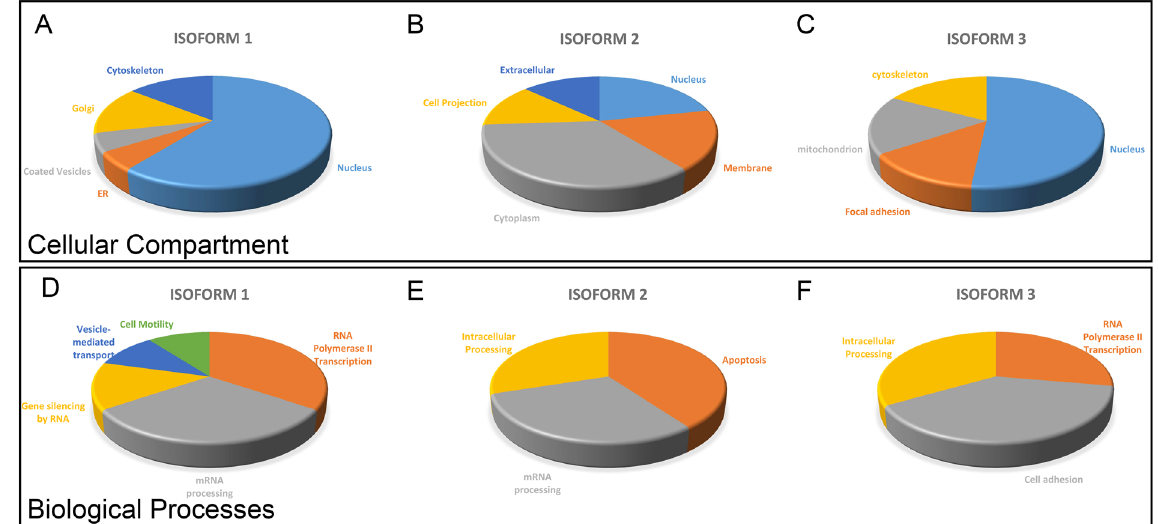
Figure 4. Gene ontology annotations enrichment for each NudCD1 isoforms. The proteins interacting with each of the NudCD1 isoforms were analysed for gene ontology annotations enrichment for cellular compartments ( A–C ) and biological processes ( D–F ) using DAVID.